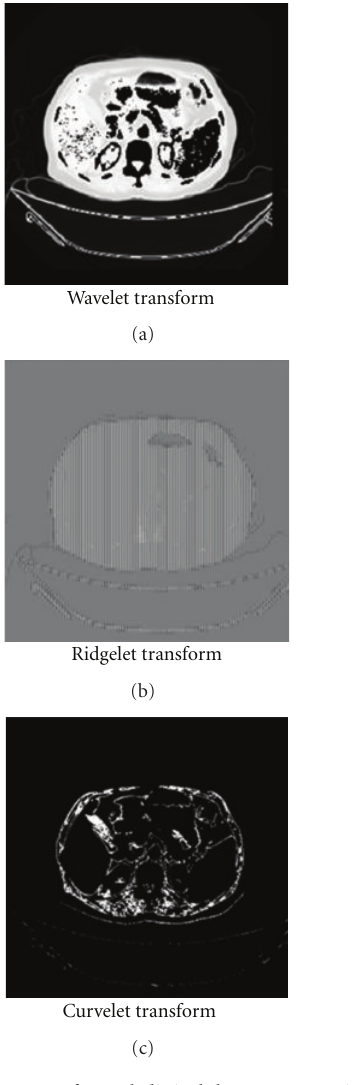
Figure 22: MRA for real clinical data segmentation.